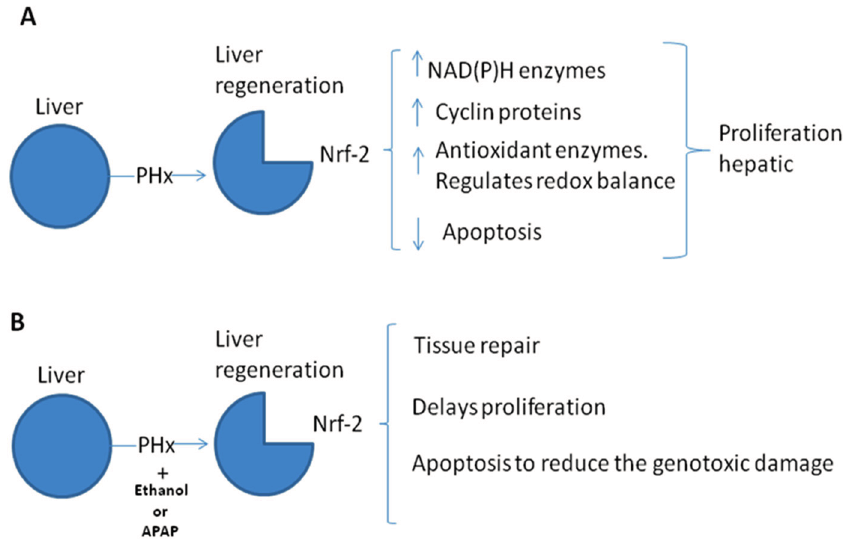
Figure 1. Schematic of the possible participation of nuclear factor-erythroid 2-related factor (Nrf-2) in liver regeneration induced by partial hepatectomy (panel A ), and when a toxic administered during liver regeneration (panel B ). PHx: partial hepatectomy; APAP: